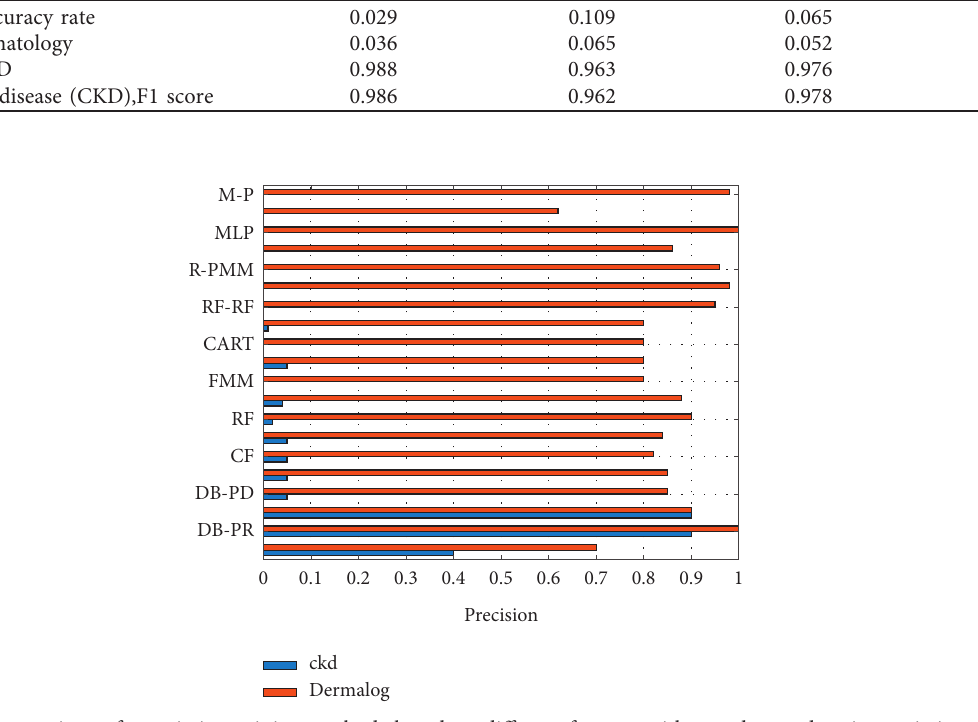
Figure 7: Comparison of association mining methods based on different features with raw data and various missing degrees.